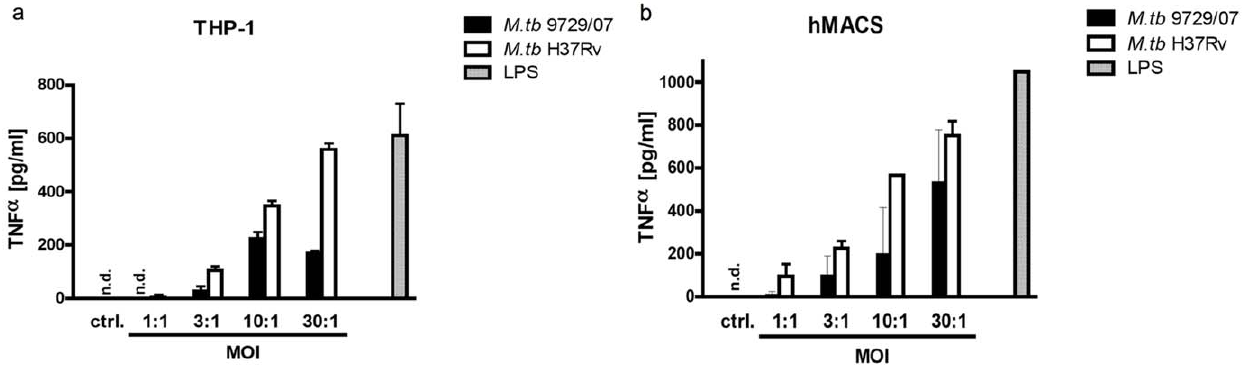
Figure 4. TNF- a production of A) human THP-1 cells and of B) human monocyte-derived macrophages (MDM) in response to the M. tuberculosis strain of the index case (9729/07) and the laboratory strain H37Rv. PMA-differentiated human THP-1 cells and MDM were incubated with indicated multiplicities of infection (MOI) of viable M. tuberculosis . Supernatants were harvested 24 h after infection and TNF levels were determined by ELISA. Data from one representative experiment of three are shown (LPS: lipopolysacharide; ctrl.: medium control, n.d.: not detectable).